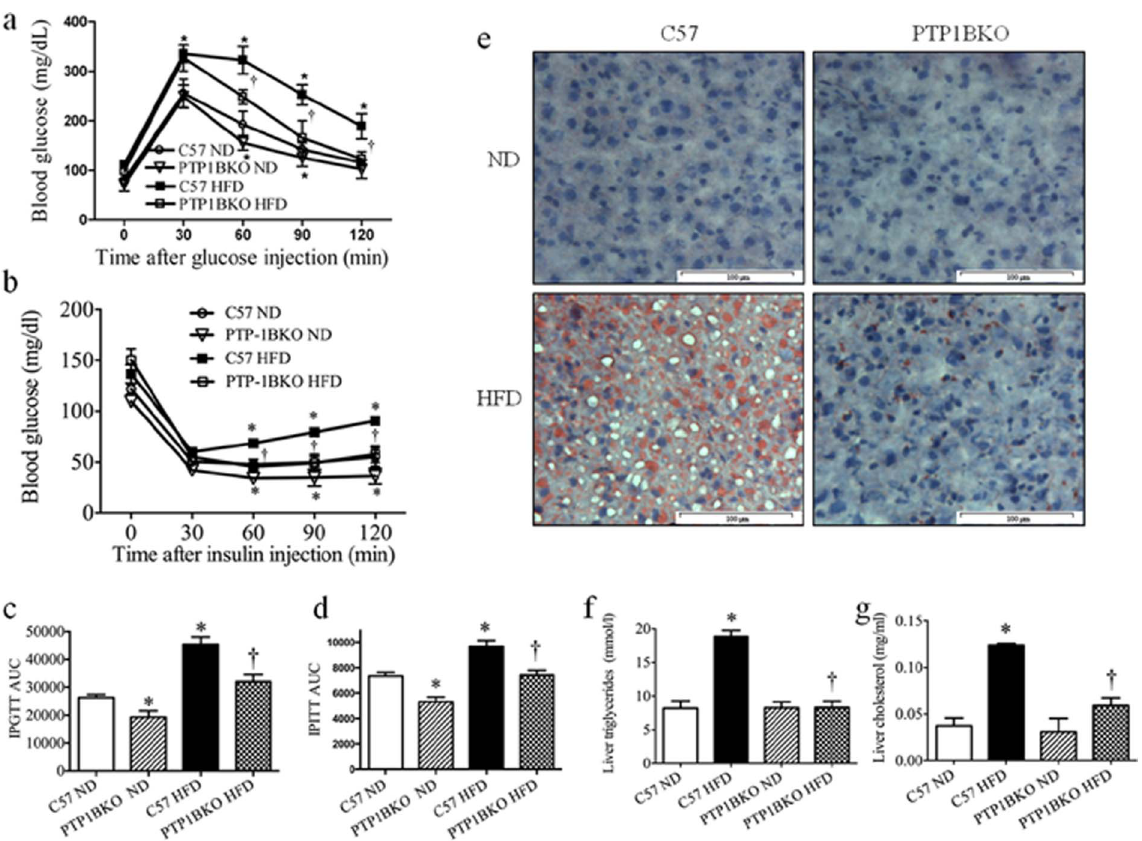
Figure 1. PTP1B knockout mice are protected against obesity-induced glucose intolerance and hepatic steatosis. Female C57 or PTP1BKO mice received normal (ND) or high-fat content (HFD) diets for 20 weeks. At the end of the experiment IPGTT (a) and IPITT (b) were performed. Area under the curve (AUC) for each individual curve of IPGTT (c) and IPITT (d) was calculated (n=6). Liver fat content was analyzed with (e) Oil Red O staining (n=6), (f) triglyceride assay kit (n=6), and (g) cholesterol quantitation colorimetric kit (n=6). Red staining – fat droplets, blue – DAPI stained nuclei. Scale bars, 100 6 m m. * p , 0.05 compared with C57 ND mice, { p , 0.05 compared with C57 HFD mice.